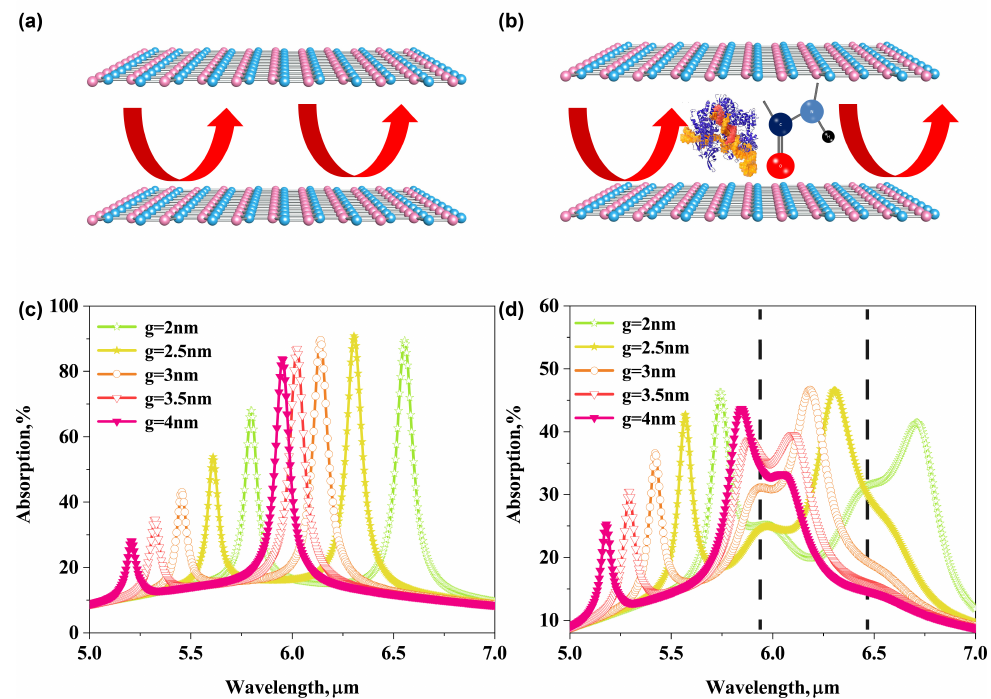
Figure 4. ( a ) Before coating protein molecules. ( b ) After coating proteins molecules, and the coupling mechanism of graphene-dielectric-graphene plasmon cavity mode and molecular vibrational finger- prints mode. ( c ) Extinction spectra of the bilayer AGPs system at varying the thickness of nano-gap. ( d ) Extinction spectra of the bilayer AGPs system with 3 nm protein inside nano-gap at varying the thickness of nano-gap. The dashed lines in this picture show the positions of vibrational band of protein